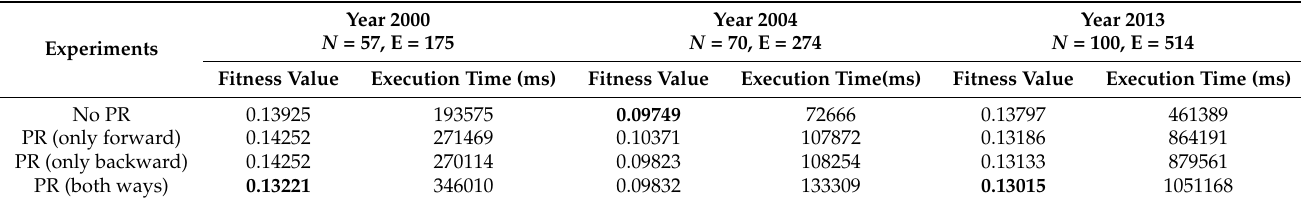
Table 5. Experiment results of various PR